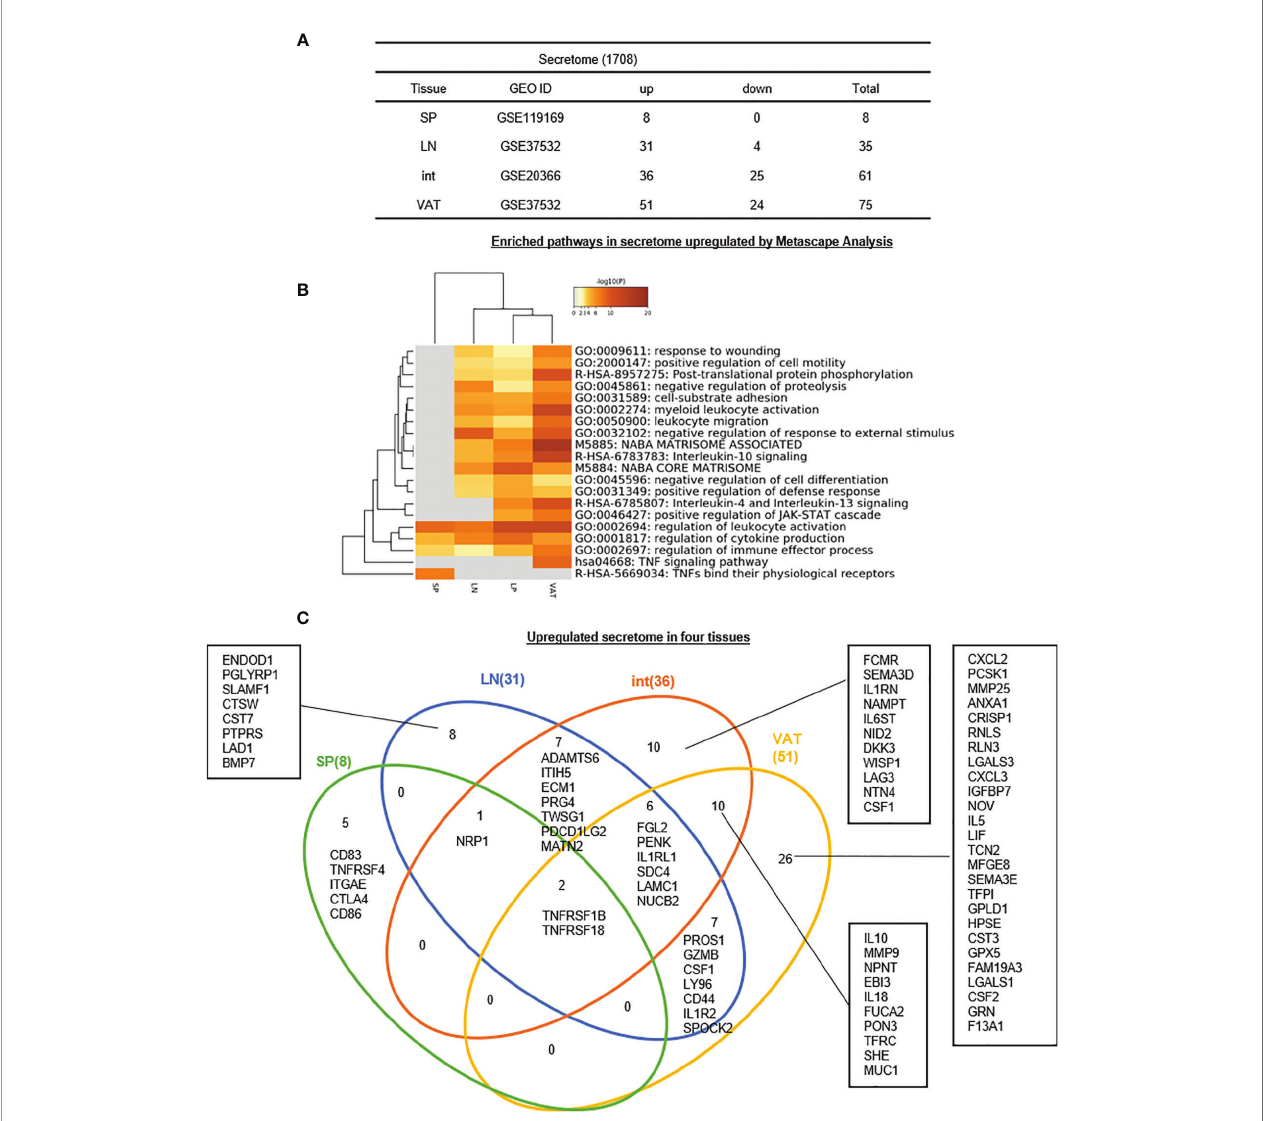
FIGURE 7 | (A – C) Five spleen Treg speci fi c secretomic genes, eight lymph nodes Treg speci fi c secretomic genes, 10 intestine Treg-speci fi c secretomic genes, and 26 VAT Treg-speci fi c secretomic genes are identi fi ed, which mediate 20 immune signaling pathways after screening for total 1,706 secretome shared (logFC) in four tissues we studied indicated that secretomic changes of Treg in different tissues could mediate the regulation of leukocyte activation, cytokine production and regulation of immune effector process by upregulated secretomic genes in Treg from four tissues we studied. See the detailed data in Supplementary Figure 6